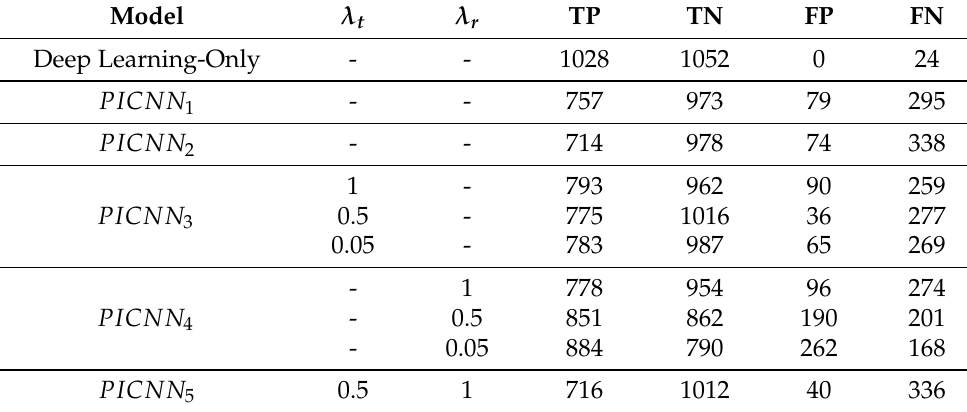
Table 3. The number of true positive (TP), true negative (TN), false positive (FP), and false negative (FN) predictions for the baseline deep learning-only model and each version of the physics-informed model when tested on the training data